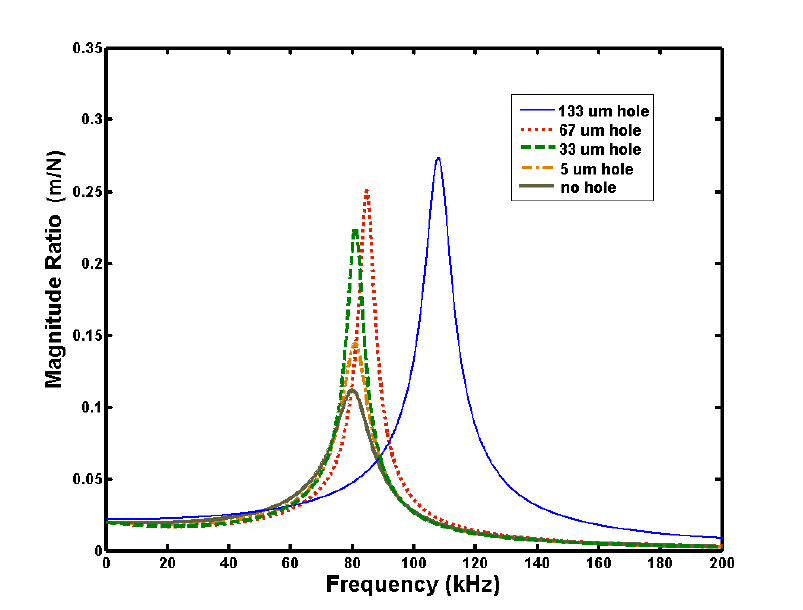
Figure 4. Effect of hole size on frequency response of square plate resonator with leg stiffness of 51.6 N/m and 3,000 Pa ambient